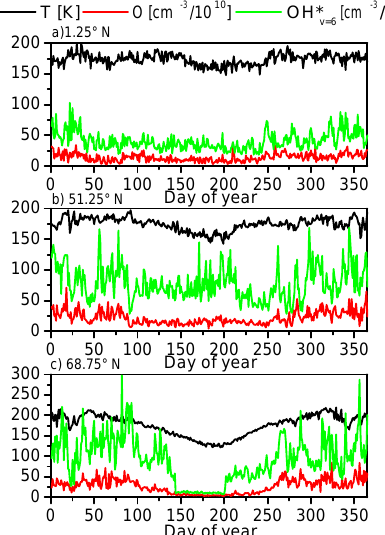
Figure 13. Annual variation in the temperature, OH ∗ density, and atomic oxygen density in 2009 at 1.25, 51.25, and 68.75 ◦ N at the height of the OH ∗ maximum. The gap in Fig. 13c in the OH ∗ den- sity around summer solstice results from the polar day condition with permanent solar insolation at this latitude and strong reduction of the ozone density as one source gas of OH ∗